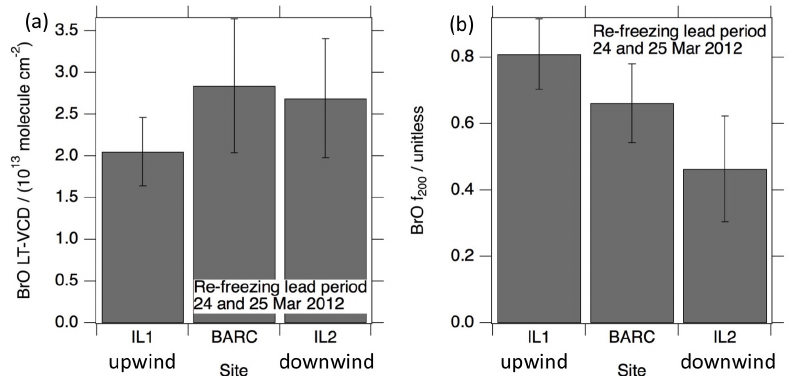
Figure 8. Average BrO LT-VCD (a) and BrO fraction in the lowest 200m, f 200 , (b) during the 2 days after the lead opening, when the lead is open and re-freezing. The bar height is the average, and error bar length is ± 1 σ . A t test for significant difference ( α = 0 . 05) shows that the LT-VCD at BARC and IL2 was significantly larger than at IL1 but that BARC and IL2 were not significantly different. For the f 200 vertical distribution metric, all three sites were statistically different from each other with a clear trend from the upwind IL1 site to the downwind IL2